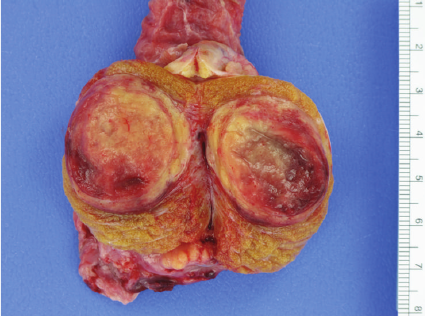
Figure 2: Gross specimen photograph of left testis showing a 3.4 cm well-circumscribed, yellow-tan mass with hemorrhagic